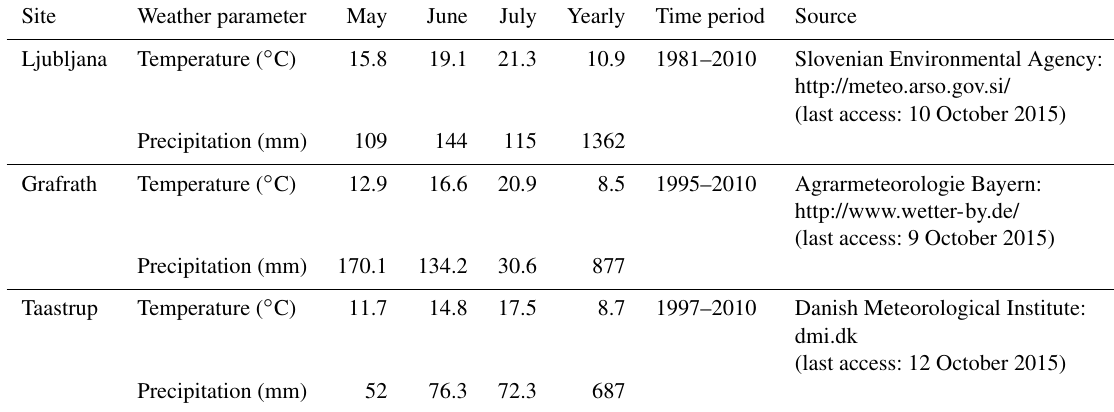
Figure 2. The daily precipitation (mm, blue) and average daily temperature ( ◦ C, red) for IPG sites Ljubljana (Slovenia), Grafrath (Germany) and Taastrup (Denmark) two weeks prior (marked in white) and during measurement campaigns (marked in grey). The error bars mark the maximum and minimum temperatures during the day. Table 1. Long-term monthly average temperature ( ◦ C) and total monthly precipitation (mm) for Ljubljana in Slovenia, Grafrath in Germany and Taastrup in Denmark (averaging period is indicated). Site Weather parameter May